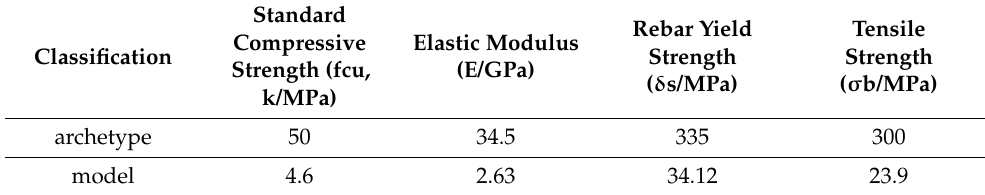
Table 1. Physical parameters of segment model.